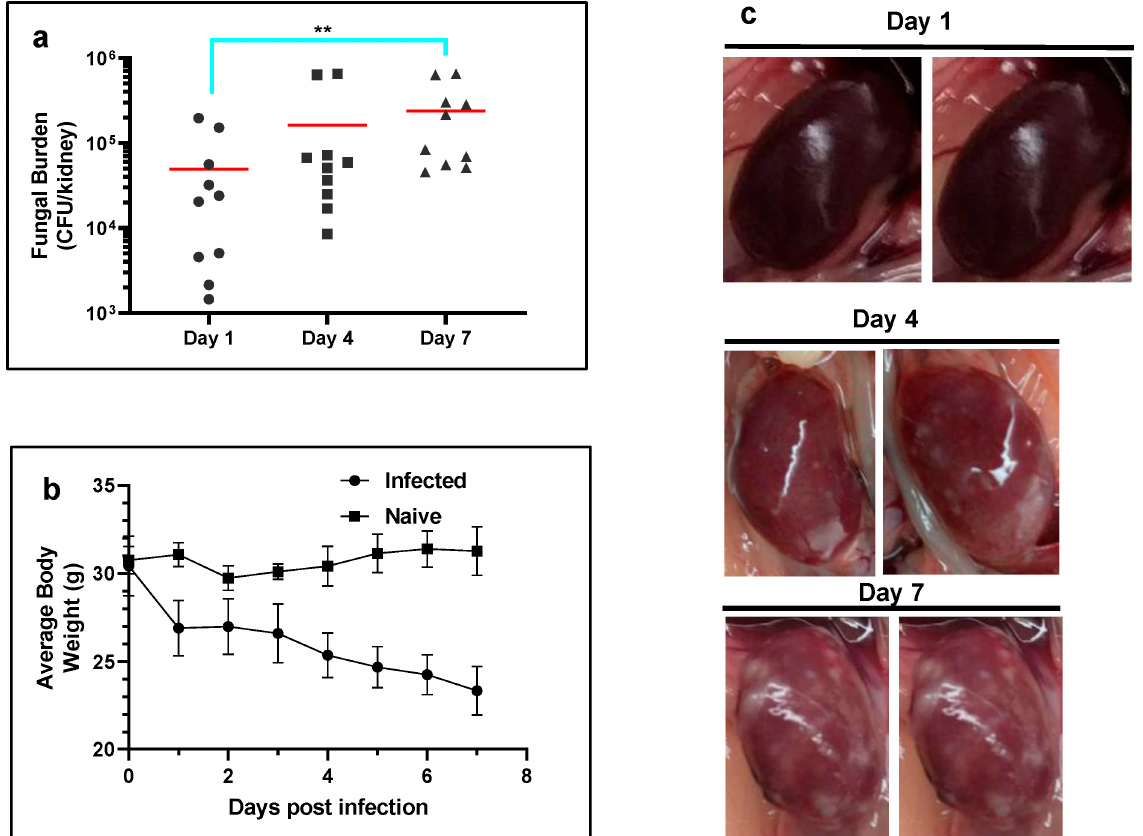
Figure 4. Development of systemic candidemia model in mice. ( a ) Temporal change in the kidney fungal burden of mice (n = 5 mice per group) infected with C. albicans . The red horizontal bar indicates the mean value. Note the significant increase in fungal burden at day 7 p.i. (** p ≤ 0.01 by Kruskal–Wallis multiple comparison test). ( b ) Average body weights of mice infected with C. albicans (n = 5 per group). ( c ) Temporal change in the gross morphology of kidneys infected with C. albicans. To determine the optimum drug concentration, we first monitored the average body weight loss with increasing concentration of itraconazole and propranolol. Mice injected with 0.25 or 0.5 mg/kg of itraconazole intraperitoneally displayed less decrease in average weight loss when compared to untreated control and mice that were treated with higher or lower concentration of the drug (Figure 5a). In addition, all (100%) mice treated with itraconazole (0.125 mg/kg) survived until the experimental end point at day 7 compared to those treated with 0.25 mg/kg (75% survival), 0.5 mg/kg (25% survival) and 1 mg/kg (25% survival). Therefore, a lower concentration (<0.125 mg/kg) of itraconazole was chosen to be used in combination with propranolol. These results suggest a possible toxic effect of the drug at higher concentrations. Mice treated with propranolol (5, 10 and 25 mg/kg) displayed no decrease in average weight loss relative to untreated mice, suggesting a lack of antifungal activity or toxicity related to the drug (Figure 5b). In addition, after necropsy, we did not observe any adverse effects in the vital organs even after treatment with elevated concentrations of propanolol or propranolol–azole